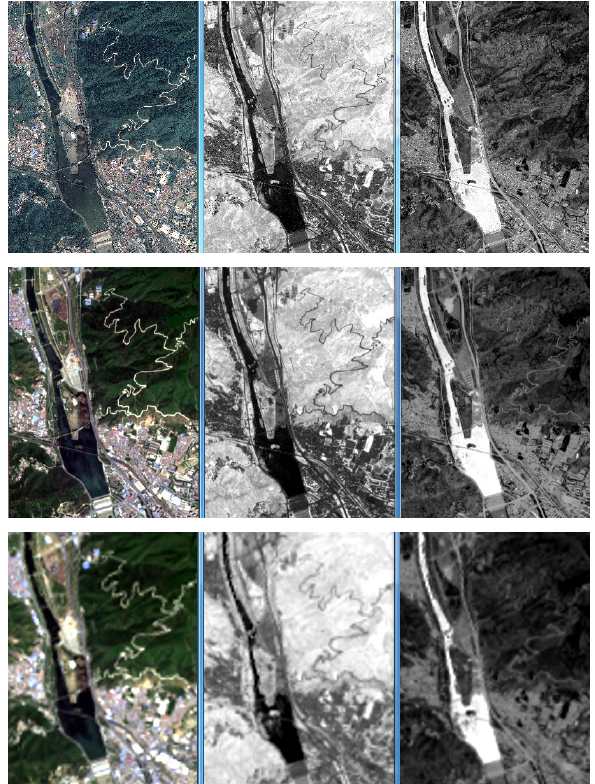
Figure 9. Comparison RGB, NDVI and NDWI images from SuperView-1A satellite for May 5, 2017 (at the up), Sentinel- 2A satellite for April 28, 2017 (in the middle) and Landsat-8 satellite for May 7, 2017 (at the bottom)